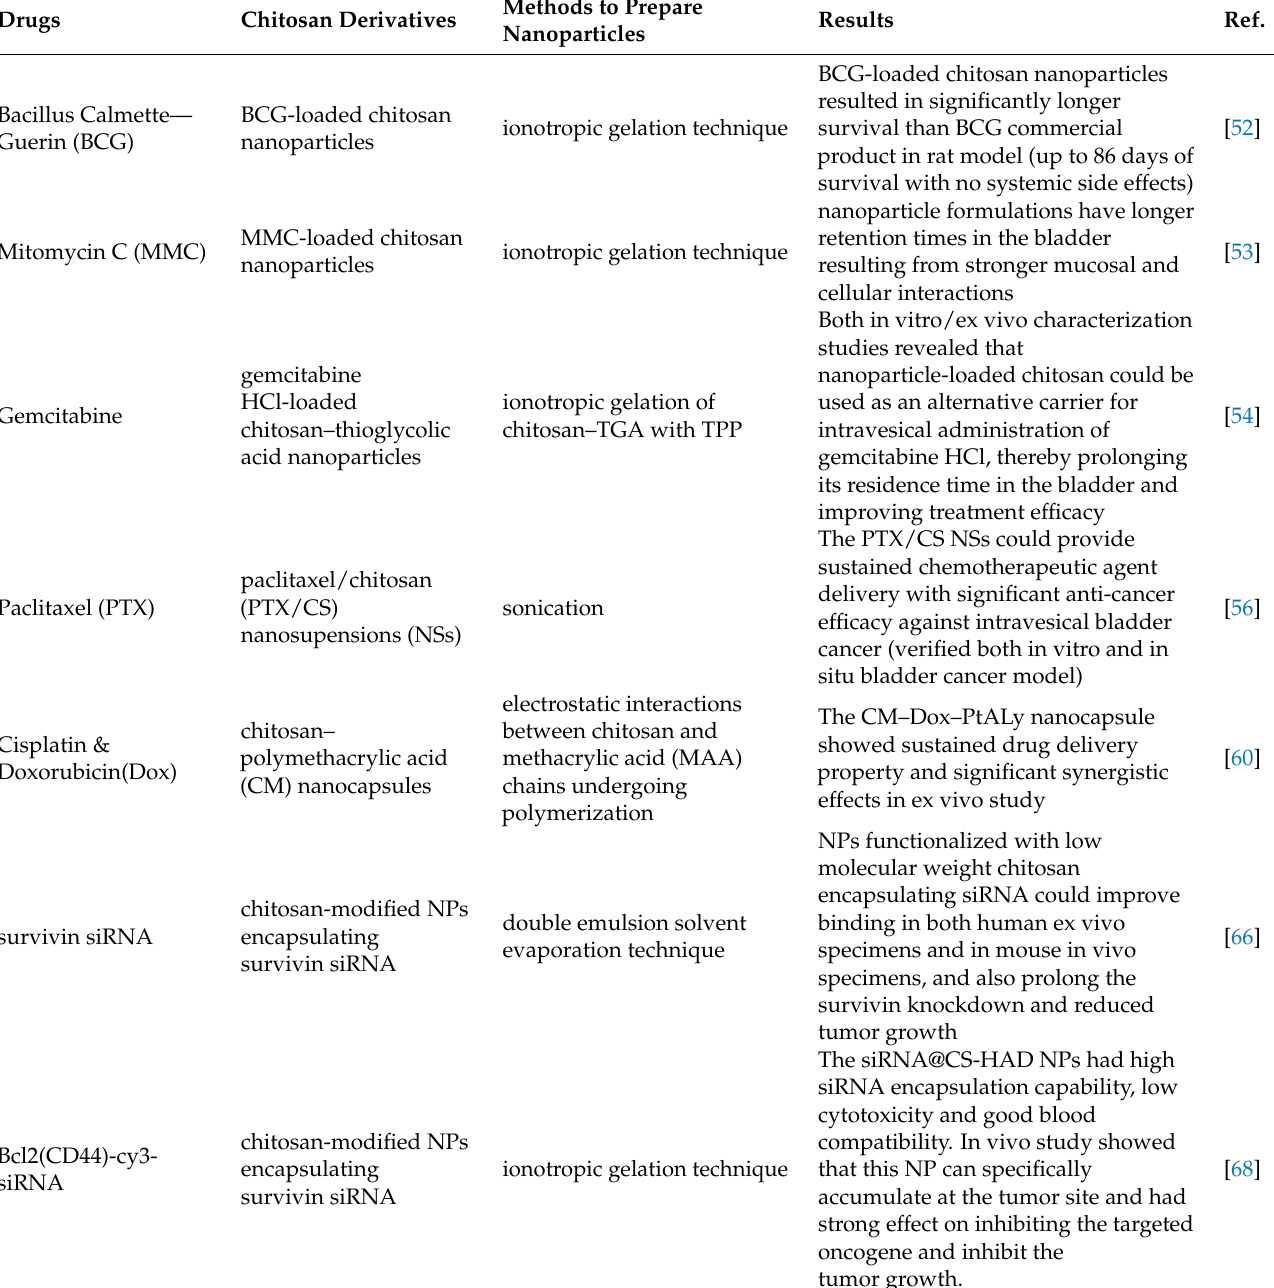
Table 2. Chitosan in intravesical drug